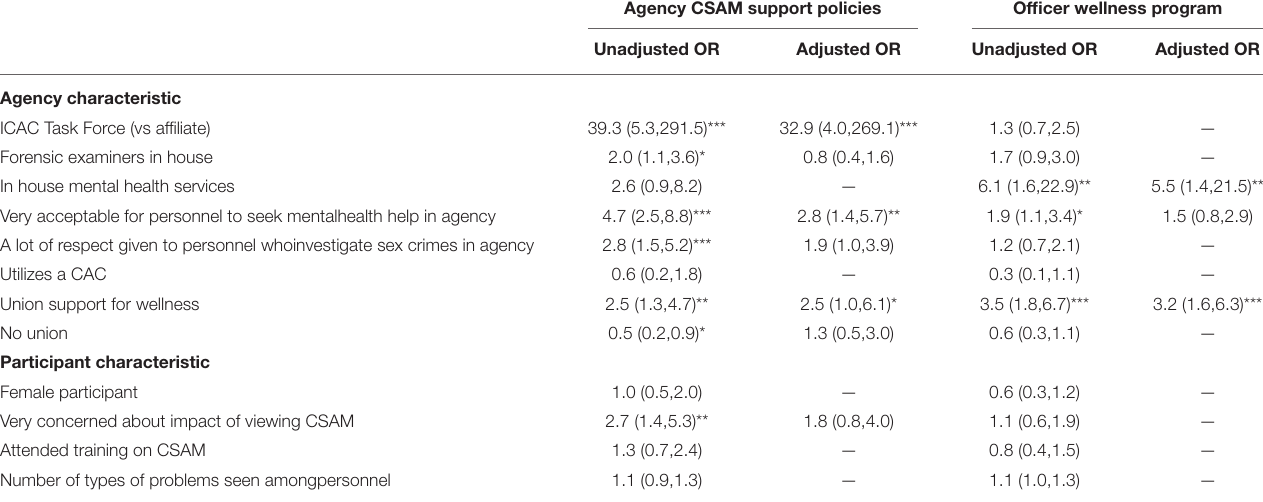
TABLE 5 | Characteristics of agencies engaging in more proactive effort around wellness—resources and